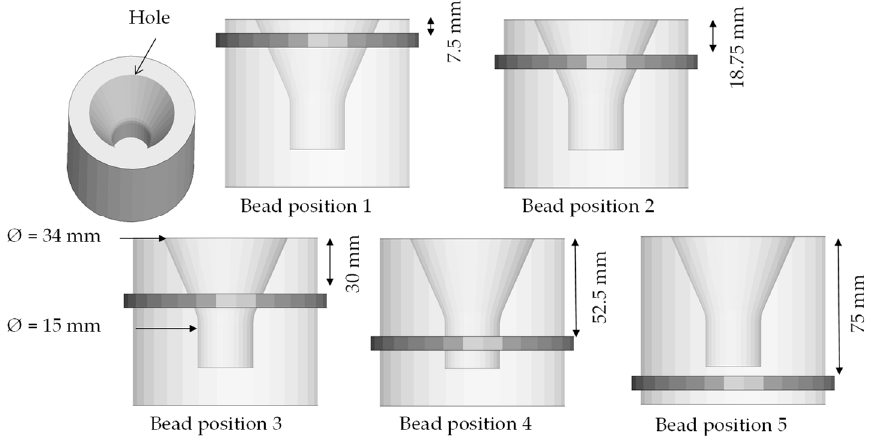
Figure 6. Welding a bead at different positions on the tool containing an internal conical hole.